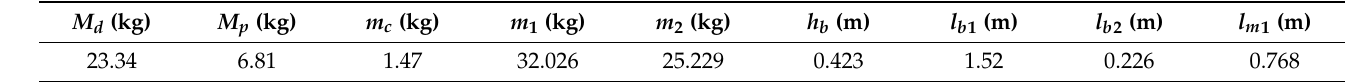
Table 1. Parameters and state